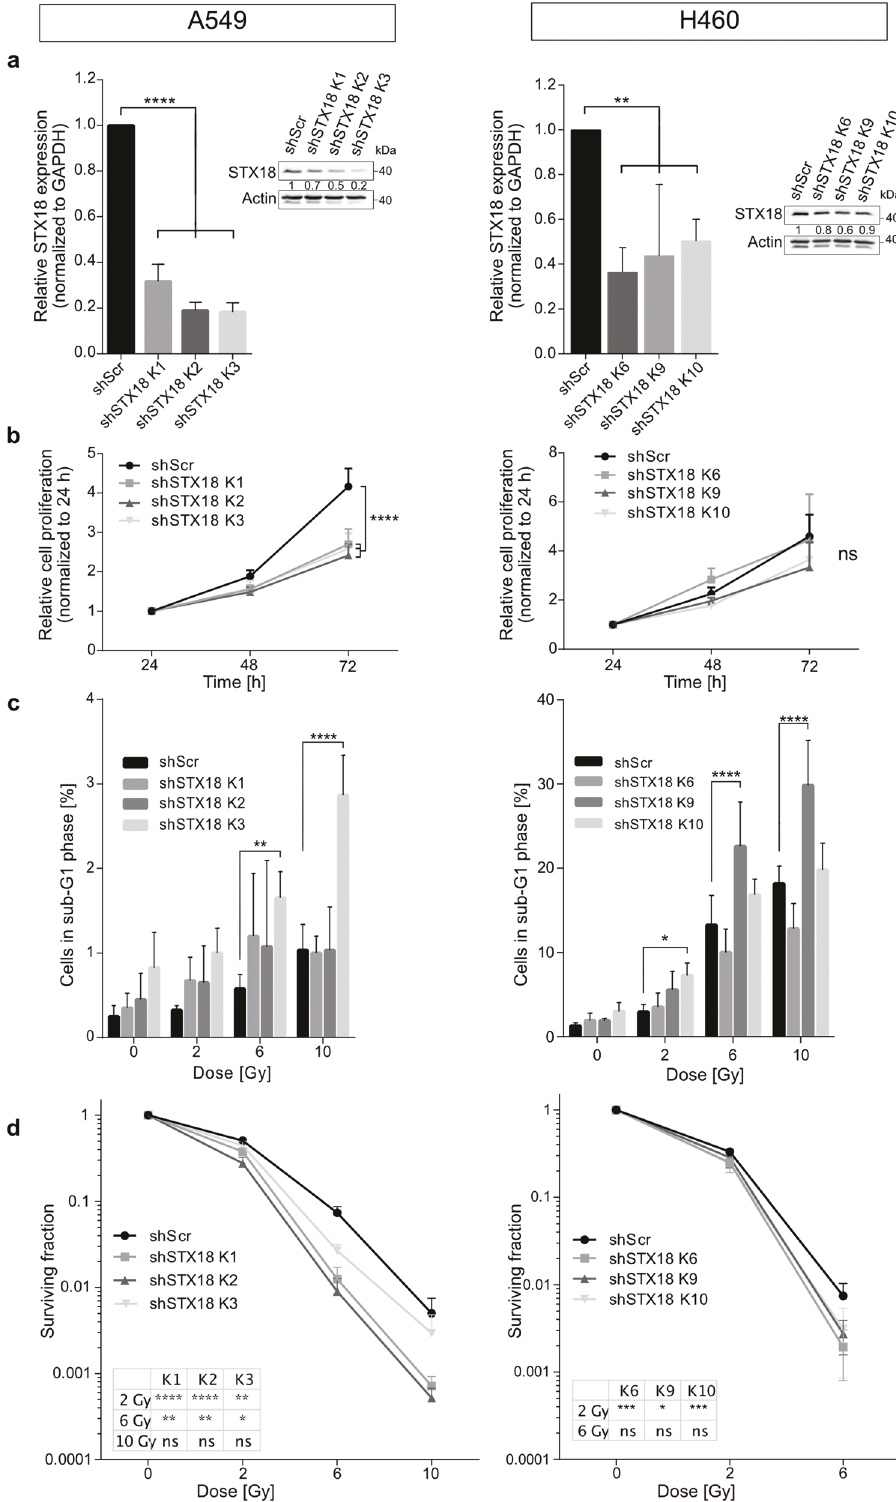
Fig. 2 STX18 knockdown sensitizes radioresistant A549 and radiosensitive H460 cell lines to irradiation. a A549 and H460 cells were transduced with a shRNA targeting STX18 and its expression was quanti fi ed by RT-qPCR. n = 3 – 4. The insert shows respective immunoblotting analyses of STX18 expression. Here, quanti fi cation was achieved after normalization to the loading control (Actin) and the shScr sample. n = 3. b Proliferation of unirradiated cells was measured by proliferation/cell viability assay. n = 3. c Quanti fi cation of sub-G1 fraction by fl ow cytometry after irradiation. Cells were irradiated and cell cycle distribution was quanti fi ed by PI staining after 72 h. n = 3 – 5. d Colony formation ability was assessed after irradiation. Cells were irradiated and colonies were counted after 10 days. n = 3.